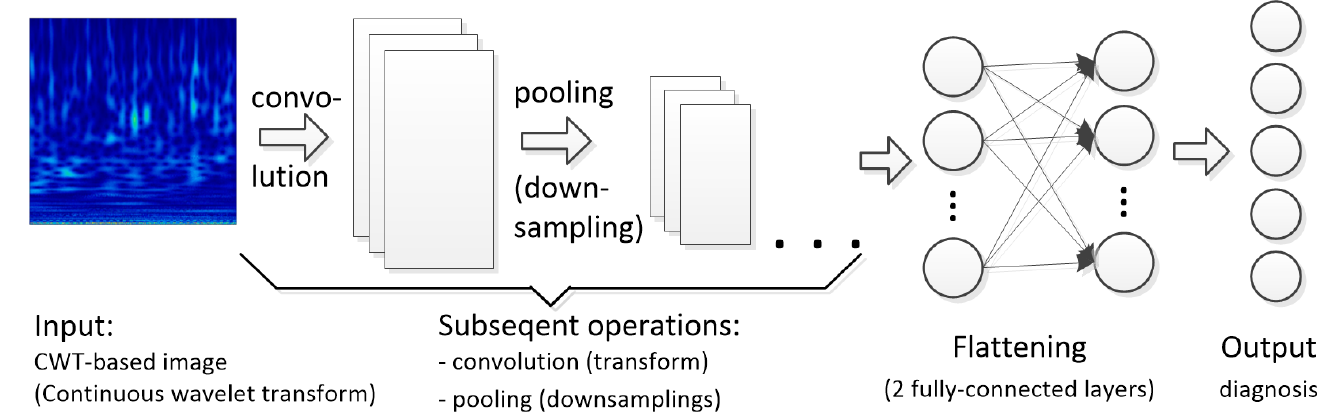
Figure 11. Structure of the CNN for fault diagnosis of a piston pump by [44].